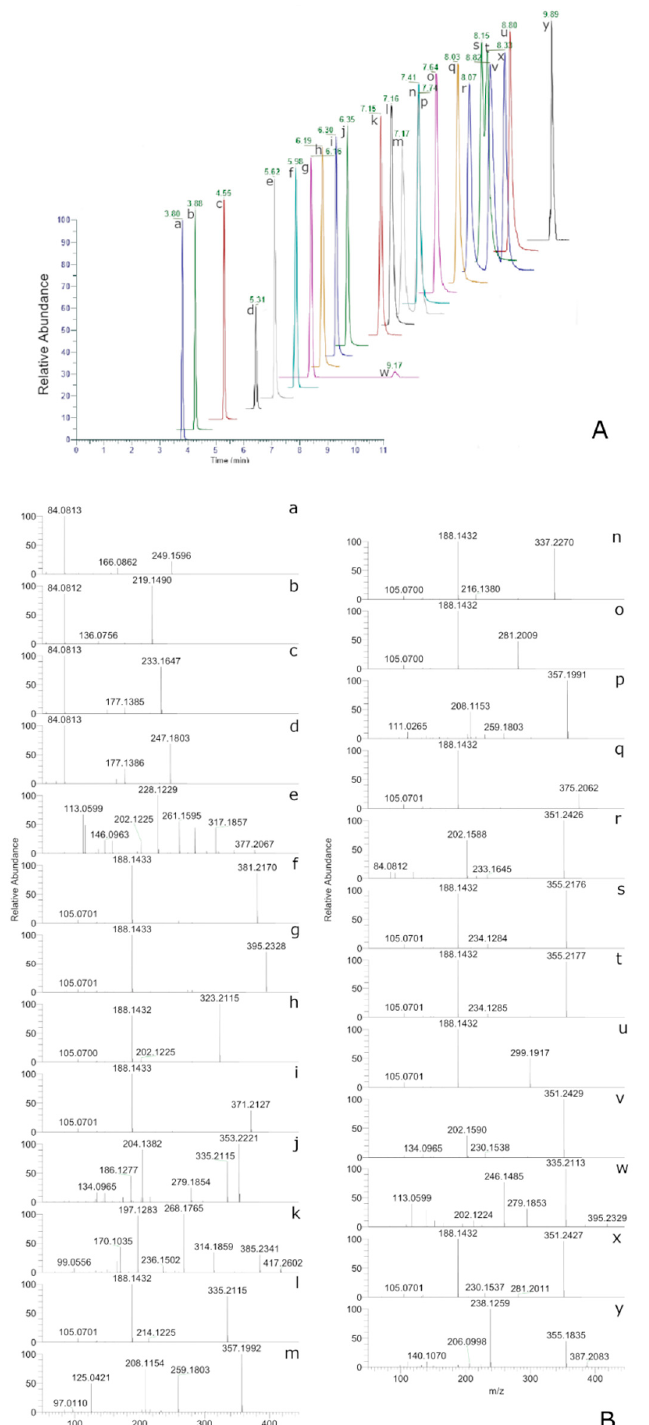
Figure 1. Chromatogram containing the extracted ion currents ( A ) and fragmentation spec- tra of target analytes, Methoxyacetyl Norfentanyl (a), Acetylnorfentanyl (b), Norfentanyl (c), +/ − trans-3-methylnorfentanyl (d), Remifentanyl (e), Butyrylfentanyl Carboxy Metabo- lite (f), Valerylfentanyl Carboxy Metabolite (g), Acetylfentanyl (h), Ocfentanyl (i), Beta- hydroxyfentanyl (j), Alfentanyl (k), Acrylfentanyl (l), alfa-methylthiofentanyl (m), Fentanyl (n), 4-ANPP (o), +/ − cis-3-methylthiofentanyl (p), Furanylfentanyl (q), +/ − cis-3-methylfentanyl (r), para-Fluorofentanyl (s), ortho-Fluorofentanyl (t), Despropionyl para-Fluorofentanyl (u), alfa- methylfentanyl (v), Carfentanyl (w), Butyrylfentanyl (x) and Sufentanyl (y) ( B